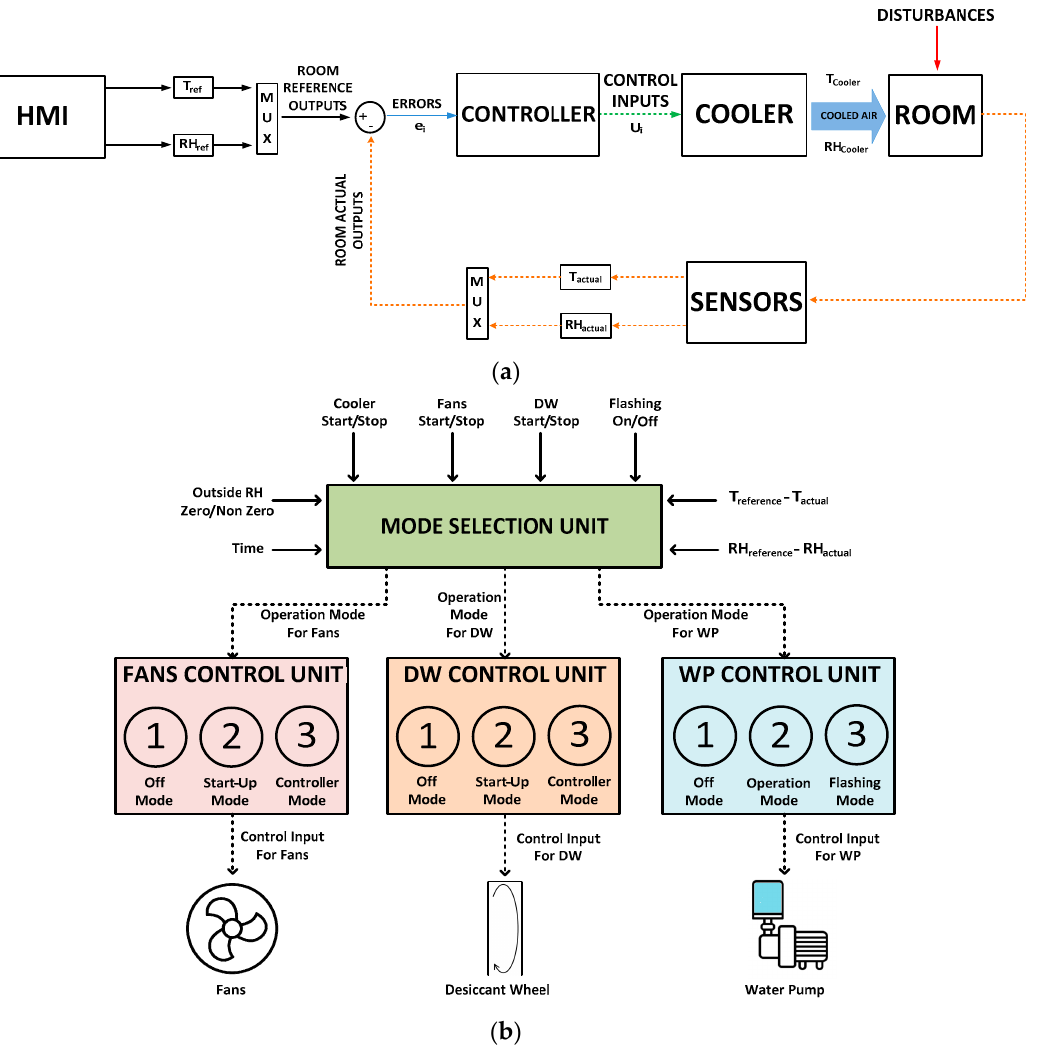
Figure 2. ( a ) Basic scheme of the proposed feedback control system. ( b ) Developed control strat-